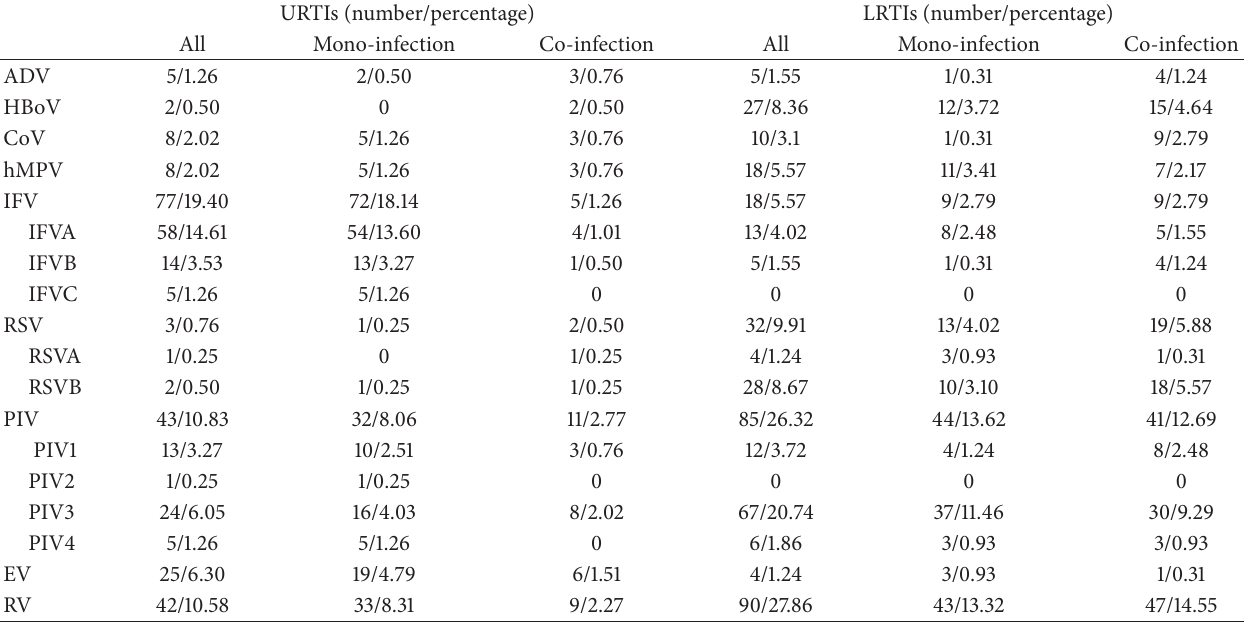
Table 2: Positive rate of coinfection with respiratory viruses versus mono-infection in patients with URTIs and LRTIs.